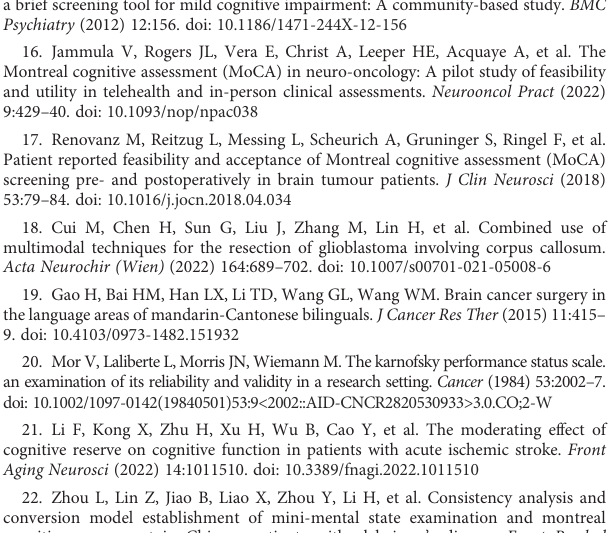
SUPPLEMENTARY FIGURE 2 The domain distribution and changes of MoCA score in perioperative period and 3 months follow-up, strati fi ed by the glioma functional locations: total changes (A, B) , primary motor cortex (C, D) , primary sensory cortex (E, F) ; premotor cortex (G, H) ; language cortex (I, J) . MoCA, the Montreal Cognitive Assessment. SUPPLEMENTARY FIGURE 3 Kaplan-Meier curve estimates of progress-free survival (A) and overall survival (B) for the patients with different preoperative MoCA score status. SUPPLEMENTARY FIGURE 4 Kaplan-Meier curve of overall survival for the patients with different preoperative MoCA score status, strati fi ed by WHO glioma grades. SUPPLEMENTARY FIGURE 5 The dynamic changes of cumulative MoCA status by different WHO glioma grades. SUPPLEMENTARY FIGURE 6 The Sankey diagram of the dynamic fl ow of neurocognitive status (normal, mild and moderate) by MoCA scores. The number indicates the cases in each MoCA test